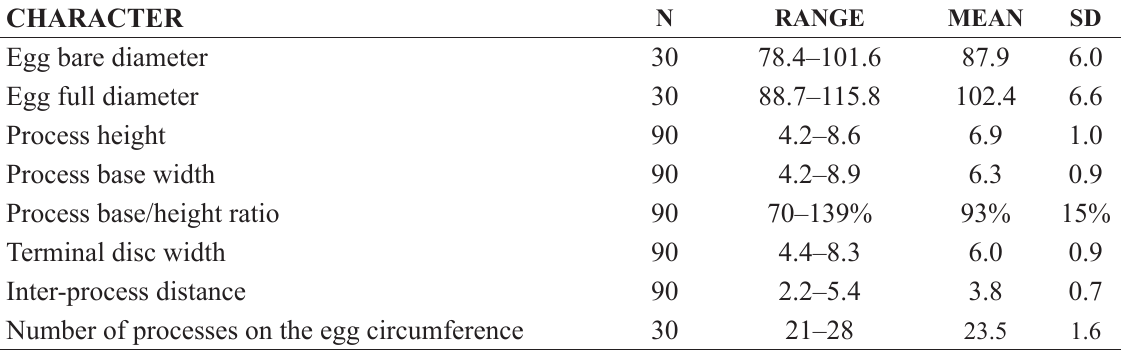
Table 3. Measurements (in μm) of selected morphological structures of the eggs of Macrobiotus engbergi sp. nov. mounted in Hoyer’s medium (N: number of eggs/structures measured; RANGE refers to the smallest and the largest structure among all measured specimens; SD: standard deviation).